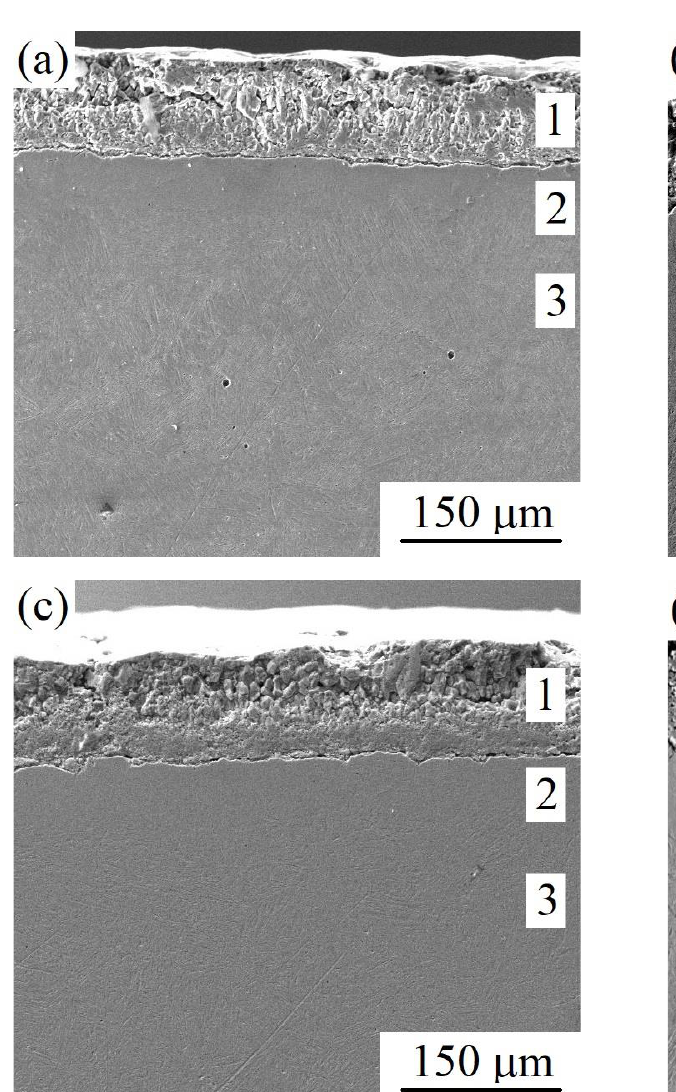
6 of 17 Table 1. Conditions of PENC and results of the samples ’ testing. PENC Time (min)